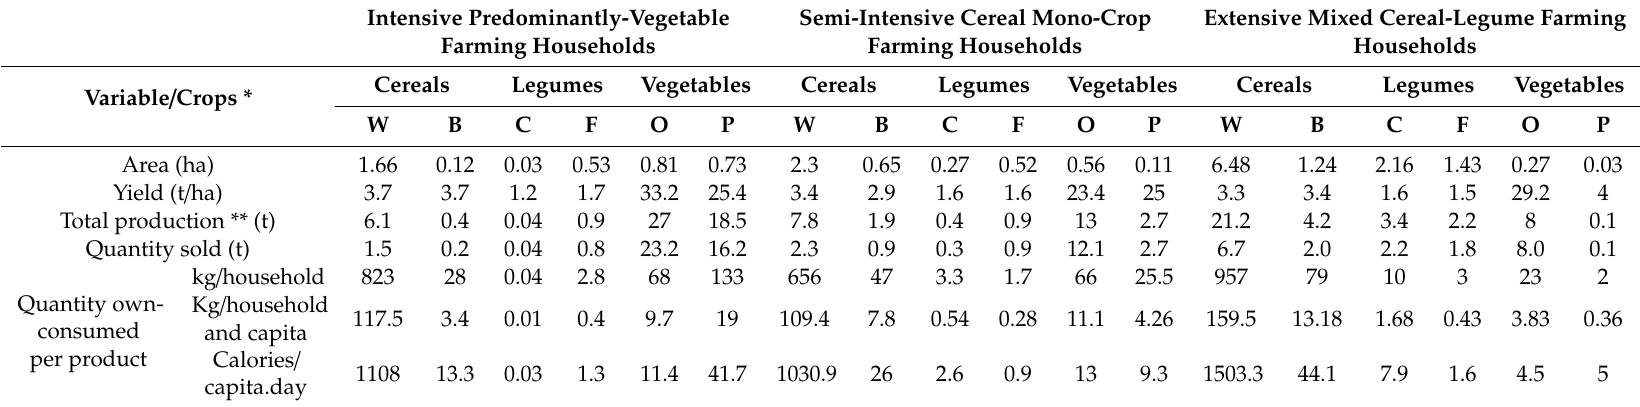
Table 5. Average crop production, average crop product sold and average self-consumed crops per farm household type. Intensive Predominantly-Vegetable Semi-Intensive Cereal Mono-Crop Extensive Mixed Cereal-Legume Farming Farming Households Farming Households Households Cereals Legumes Vegetables Cereals Legumes Vegetables Cereals Legumes Variable / Crops *